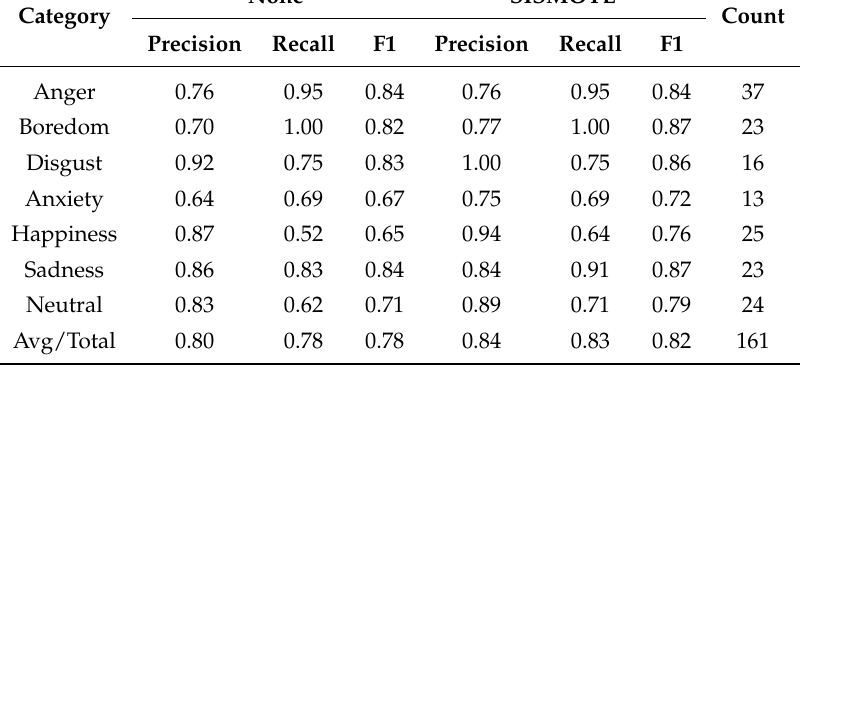
Table 1. Comparative results in the initial samples and the samples after using SISMOTE on Emo-DB. None SISMOTE Category Precision